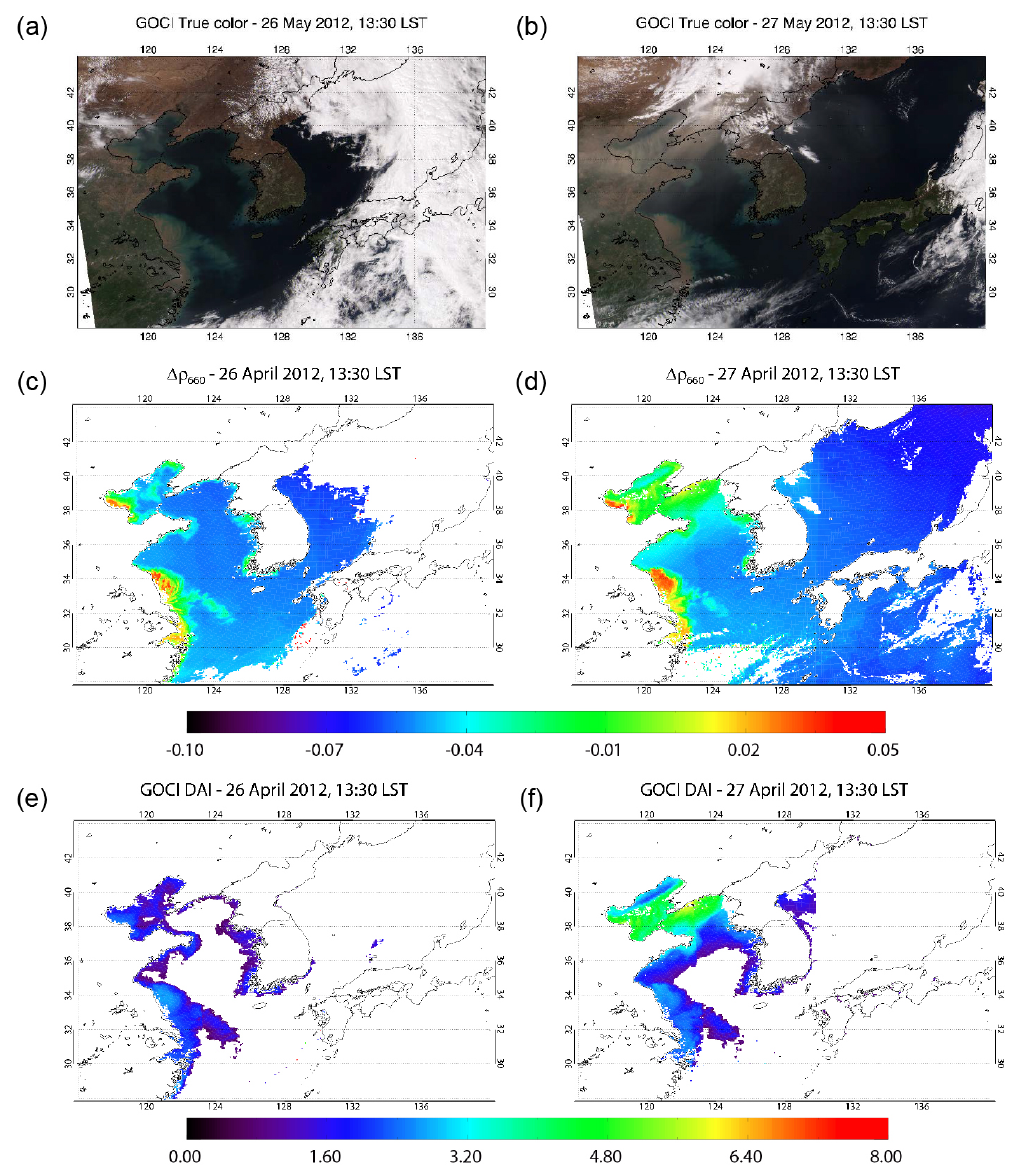
Figure 4. (cid:49)ρ 660 and DAI images at 13:30LST on (a) , (b) 26 April 2012 (no dust case) and (c) , (d) the following day (dust case),